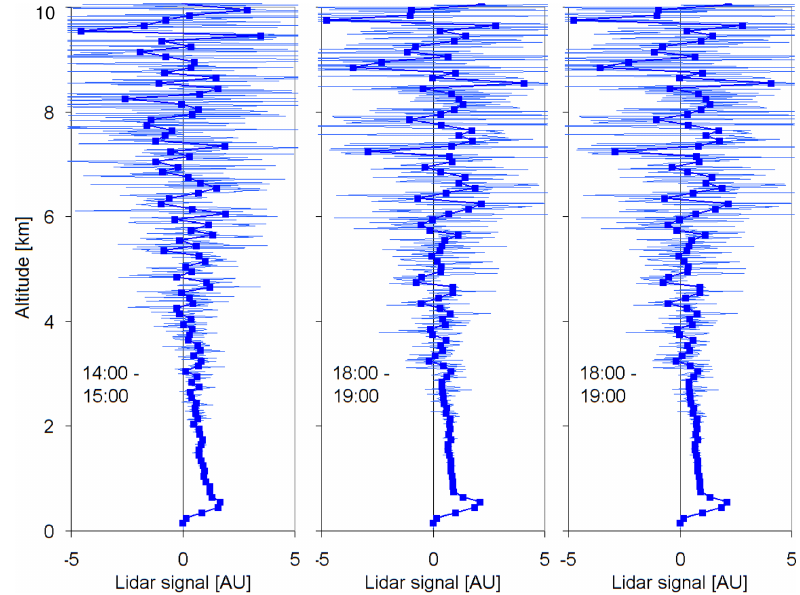
Figure 4. Hourly averaged and range-corrected ceilometer backscatter profiles for three periods on 2 May 2019 without cloud contamination. The thin lines represent the raw data. The dotted lines represent the smoothed profiles (averages over 100m). The scatter of the range- corrected backscatter profiles increases because the received raw signal scales with the inverse of the square of the